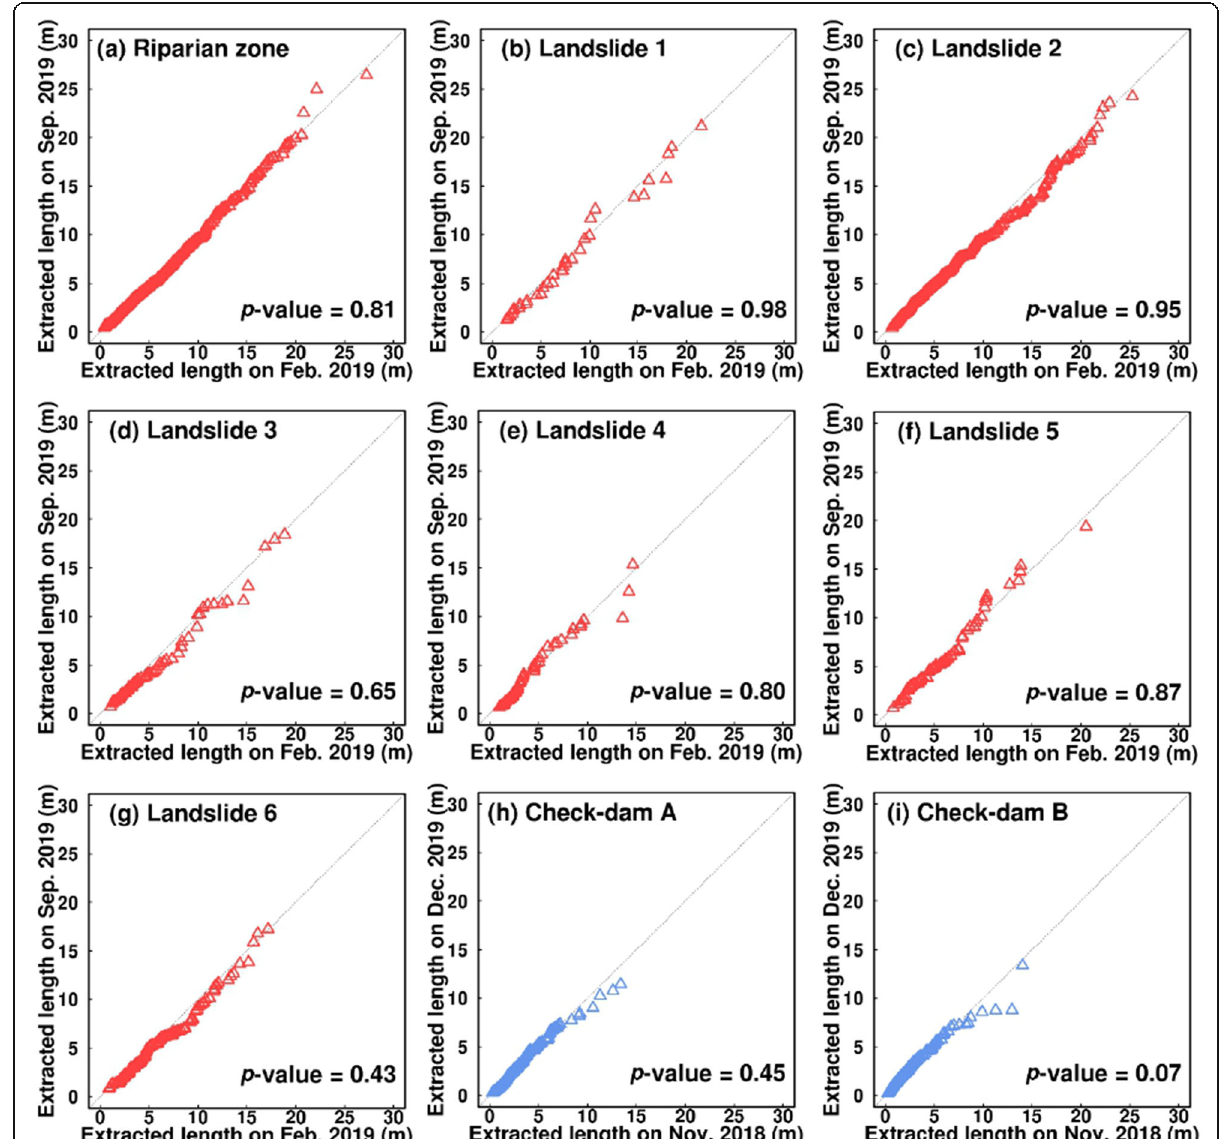
Fig. 12 Q – Q plots for the lengths of the extracted wood pieces: a – g the coniferous forest (CF) site and h – i the broadleaf forest (BF) site. The p - value indicates the result of the goodness-of-fit test (the Kolmogorov – Smirnov